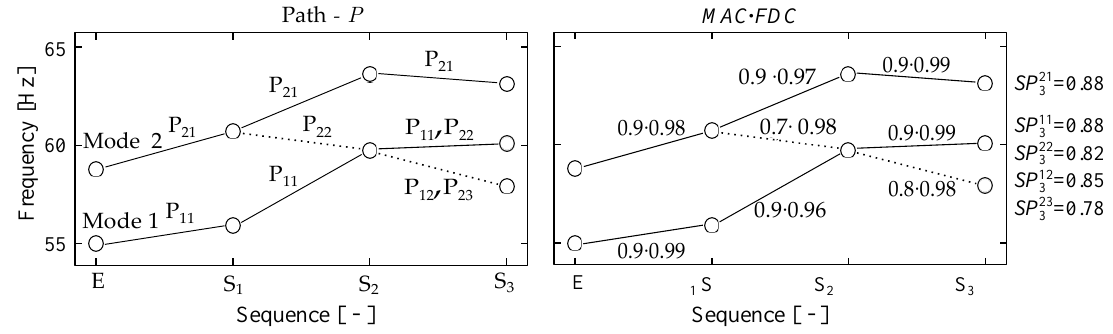
Figure 7. Paths derived from sequential determined frequency shifts of multiple modes ( left ) with associated modal assurance criterion (MAC) and frequency deviation correlation (FDC) values ( right ).